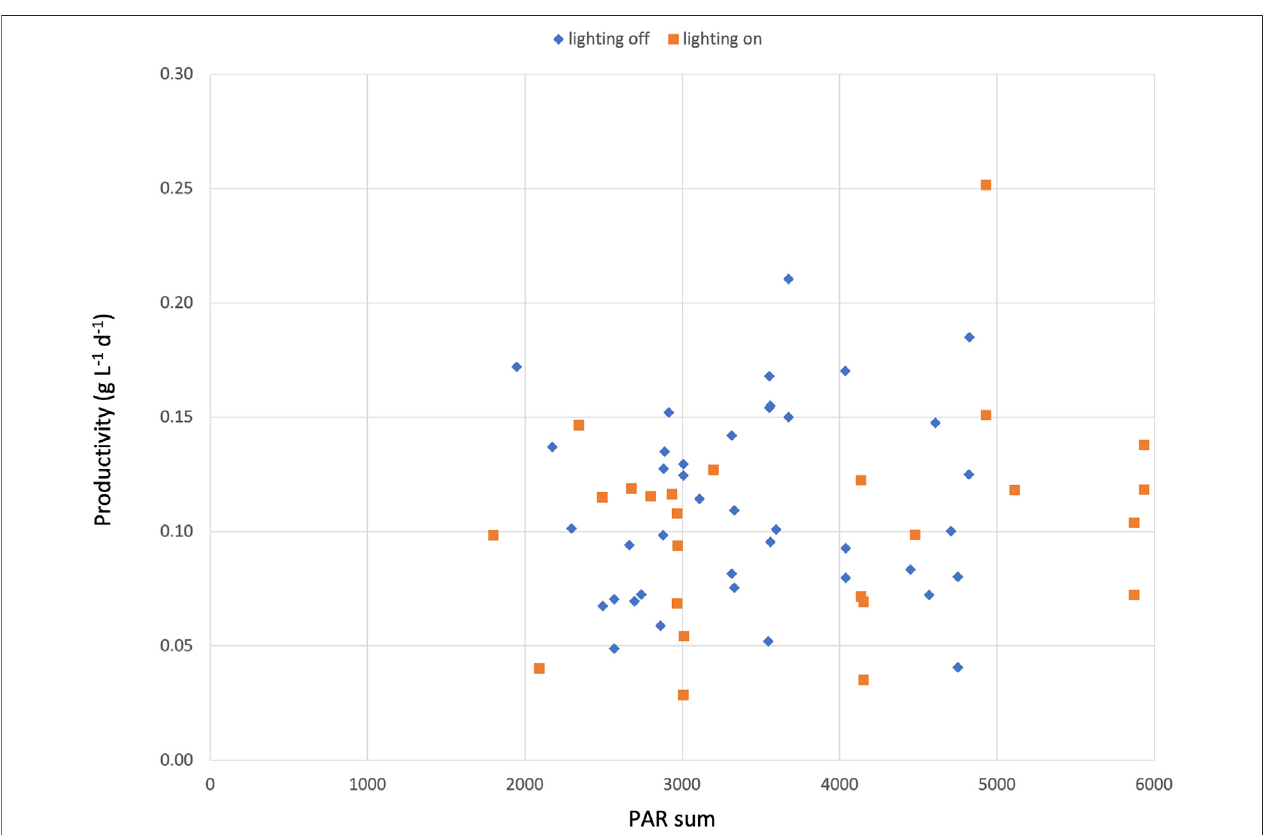
FIGURE 4 | Daily productivity of C. typhlos (g L − 1 d − 1 ) and PAR sum of each speci fi c day during the two growth periods. Each square represents 1 day.